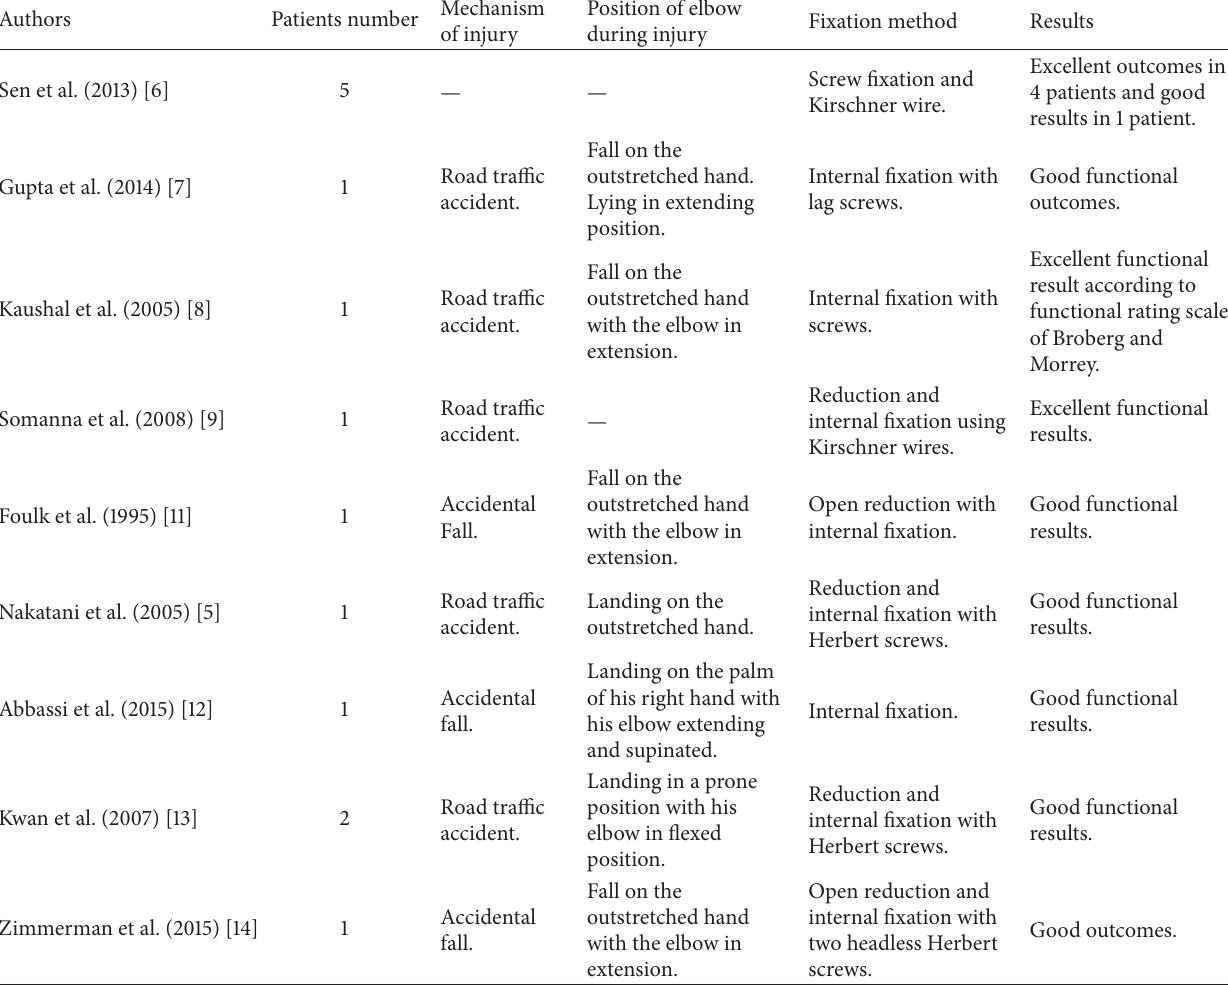
Table 1: Surveys found in the literature reporting details of patients managed for isolated fracture of the